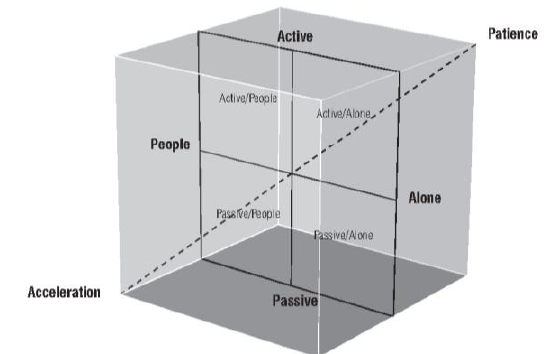
Figure 33: Perspective of the Assessing Cube – AP3 ( Hay, 2009 p. 191)